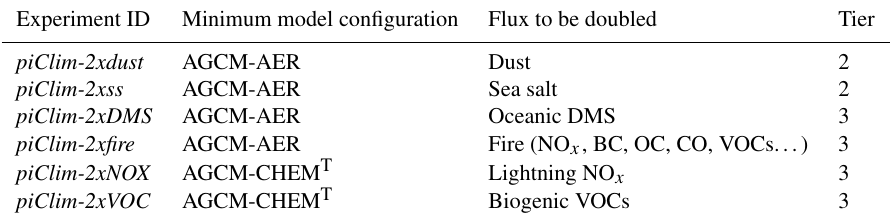
Table 7. List of fixed SST simulations for ERFs of natural emitted species. These are time-slice experiments of 30 years in total, using climatological average SST and sea ice distributions. The “AER” suffix means that at least interactive aerosols are required. The “CHEM T ” suffix means that at least tropospheric chemistry is required. Models should always be run with the maximum complexity available. The specified natural emission flux should be doubled compared to the pre-industrial control, either scaling the parameterisations in an interactive scheme or the data files for specified emissions. All other forcing agents should be as in the pre-industrial control. Experiment ID Minimum model configuration Flux to be doubled Tier piClim-2xdust Dust 2 piClim-2xss AGCM-AER Sea salt 2 piClim-2xDMS AGCM-AER Oceanic DMS 3 piClim-2xfire AGCM-AER Fire (NO x , BC, OC, CO, VOCs...) 3 piClim-2xNOX AGCM-CHEM T Lightning NO x 3 piClim-2xVOC AGCM-CHEM T Biogenic VOCs